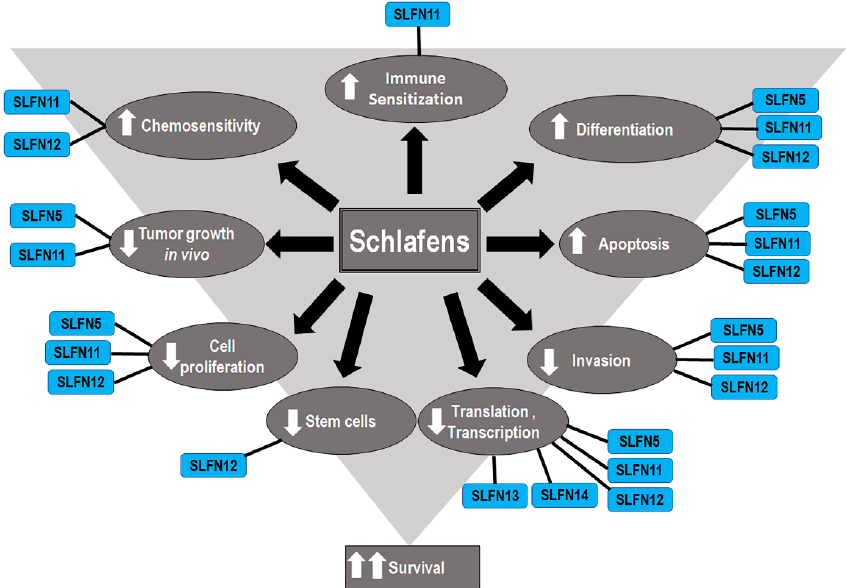
Figure 2. Diagram illustrates the identified effects of different Schlafens on cancer cell biology. The reduced cell proliferation, differentiation, invasion, and stem cells, in addition to the increased differentiation, immune sensitization, and chemosensitivity, all contribute to improved survival. Table 1. Summary of the roles of human Schlafens in different cancer types. Each Schlafen expres- sion level and the correlation with survival were identified. The non-cited data are derived from our analysis of publicly available tools (https://www.proteinatlas.org, July 10, 2021) and (https://kmplot.com/analysis/July 10, 2021).